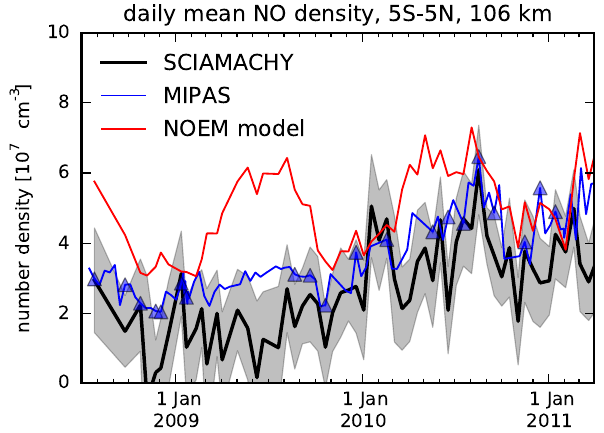
Fig. 13. Equatorial daily mean nitric oxide number density at 106km, SCIAMACHY MLT (black) and MIPAS UA (blue) com- pared to the NOEM model (red) (Marsh et al., 2004) based on SNOE data (Barth et al., 2003). The grey shaded area shows the 3 σ confidence interval of the SCIAMACHY daily means and the blue triangles indicate coincident SCIAMACHY MLT and MIPAS UA measurement days.